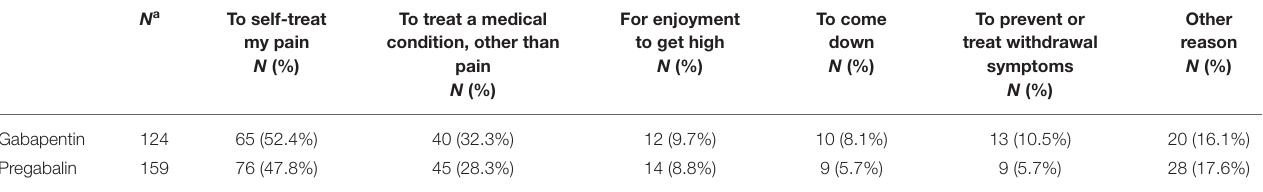
TABLE 5 | Reasons for non-medical use in the Spanish